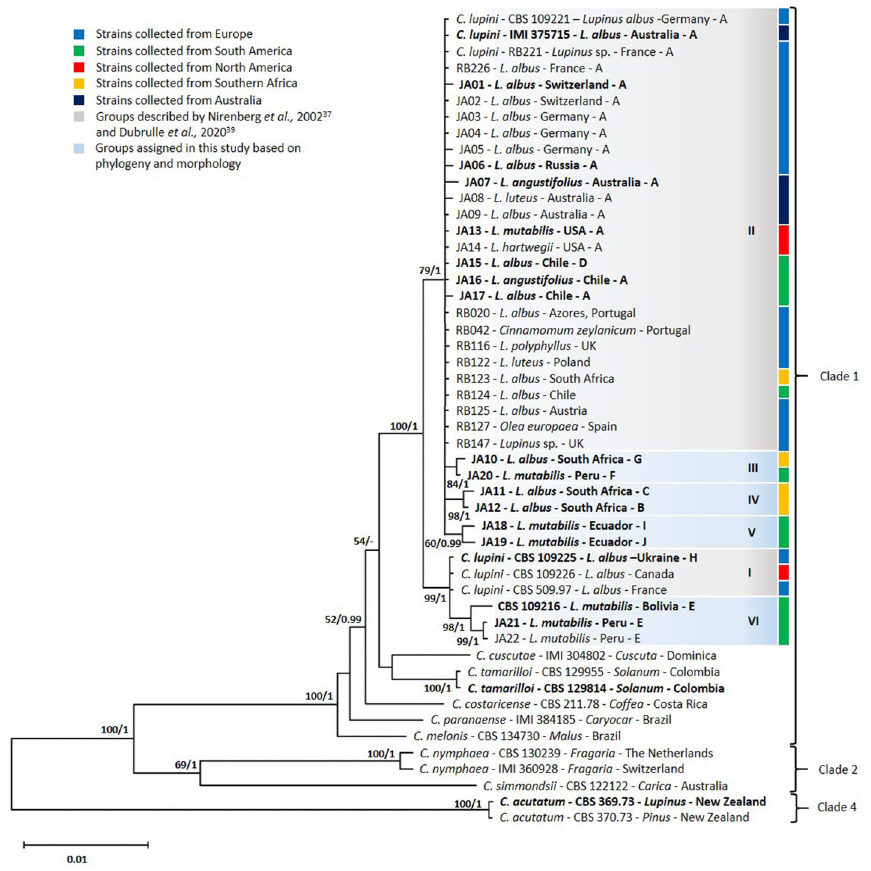
Figure 3. Multi-locus phylogeny of Colletotrichum lupini . Bayesian analysis tree inferred from the combined ITS, TUB2, GAPDH and APN/MAT1 sequence datasets of 50 Colletotrichum strains used in this study. Bootstrap support values (> 50) and Bayesian posterior probabilities (> 0.95) are given at each node. The tree is rooted to C. acutatum (CBS 369.73 and CBS 370.73). Strain codes are followed by host, country of origin and morphology (A–J). Grouping (I–VI) is based on phylogeny and morphology. Strains used for virulence assays are highlighted in bold. Clades indicate the different clades within the C. acutatum species